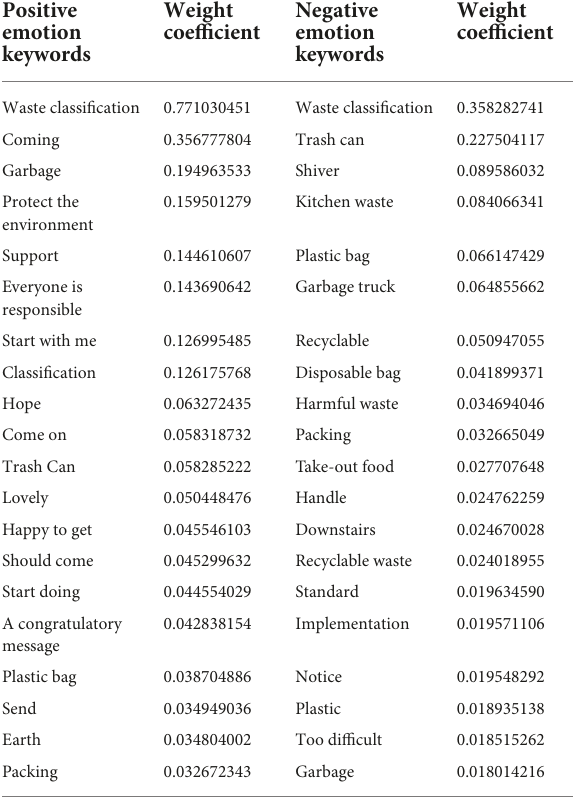
TABLE 5 Perceptual word weight coefficient